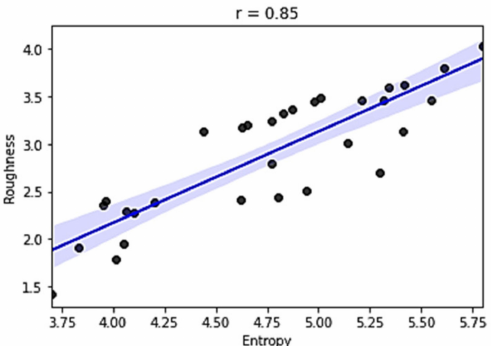
Figure 23. Relationship between data entropy value and roughness.